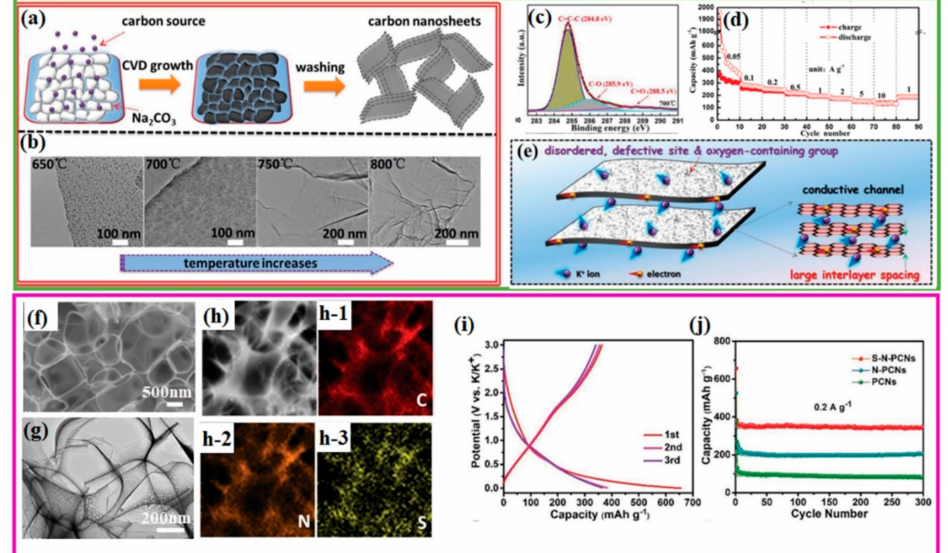
Figure 7. Carbon nanosheets as anode for post-Li capacitors. ( a – e ) Oxygen-rich carbon nanosheets (CNS) for potassium-ion hybrid capacitor: ( a ) schematic illustration of the growth of CNSs and ( b ) TEM images of CNSs obtained at different deposition temperatures, ( c ) C 1s XPS analysis of CNS deposited at 700 ◦ C, ( d ) rate capability of CNSs, ( e ) schematic illustration of the unique features of CNS as anode material in potassium-ion batteries. Reproduced with permission [58], Copyright 2019, Wiley-VCH. ( f – j ) S,N-doped porous carbon nanosheets (S-N-PCNs) as anode for potassium-ion capacitors: ( f ) SEM image, ( g ) TEM image, and ( h ) EDS mapping of C, N, and S in the S-N-PCNSs, ( i ) charge–discharge curves, and ( j ) cycling performance of S-N-PCNs. Reproduced with permission [59], Copyright 2019,